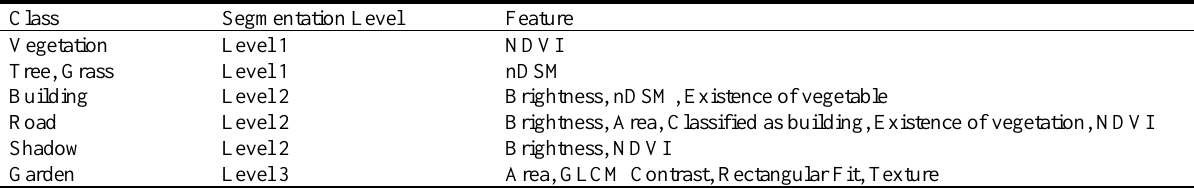
Table 3. Object’s features used in the rule-set hierarchy for different classes